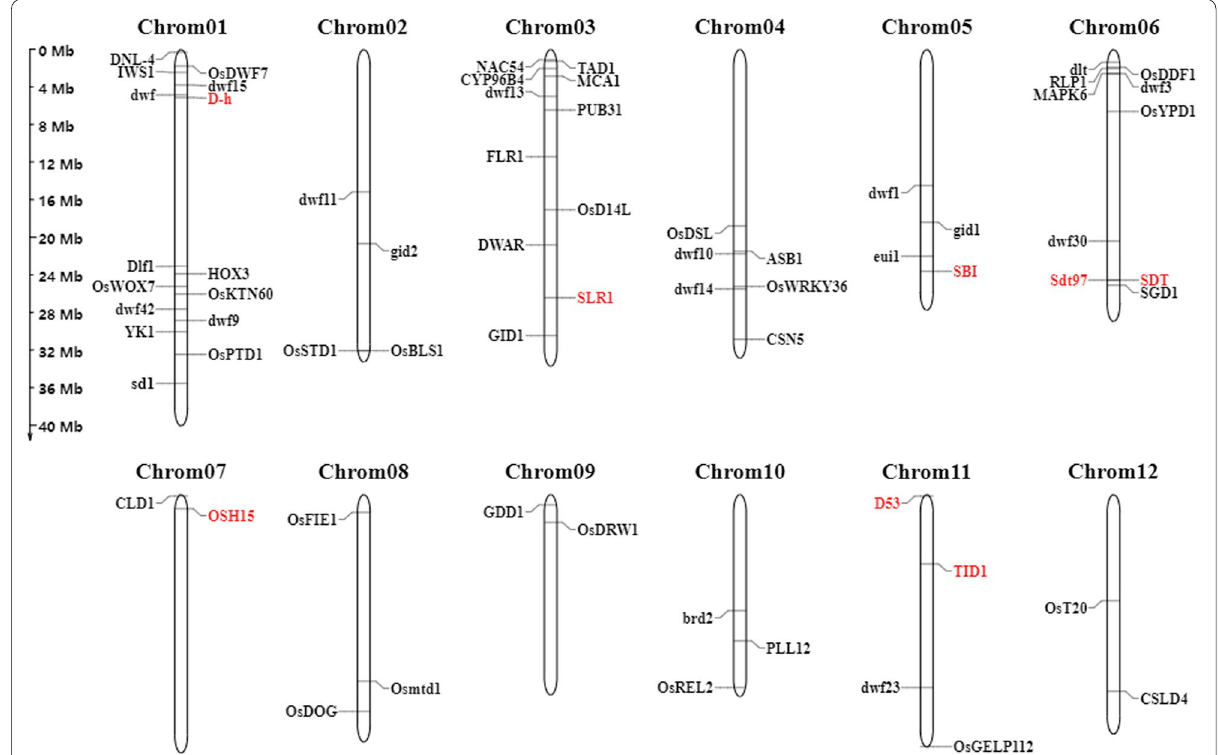
Fig. 2 Sixty-six dwarf and semi-dwarf genes obtained from the Rice Annotation Project Database (https:// rapdb. dna. affrc. go. jp/). The genes in red are discussed in the following text. The chromosomal locations of these genes are determined using the program Map Gene 2 Chromosome V2 (MG2C) (Chao et al.